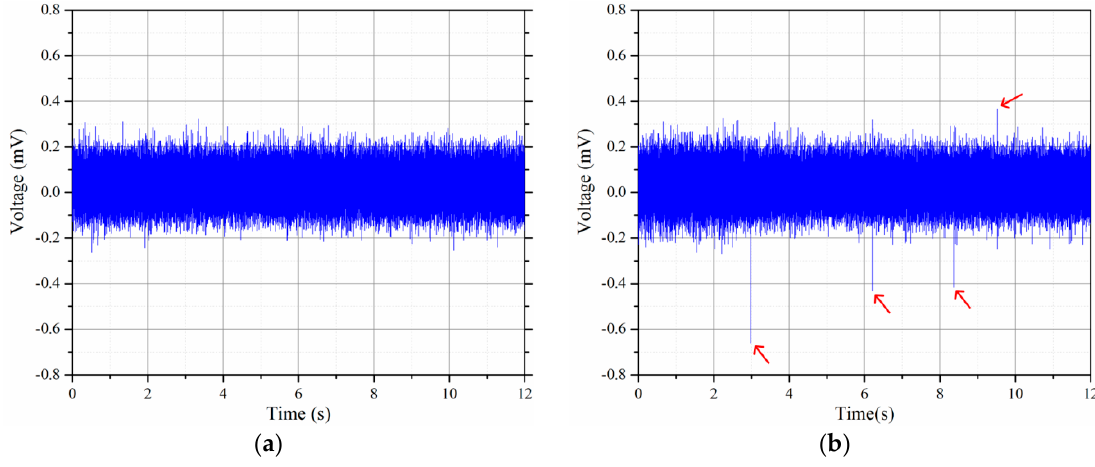
Figure 15. Results of the oil sample ( a ) without debris and ( b ) with <13 μ m debris.